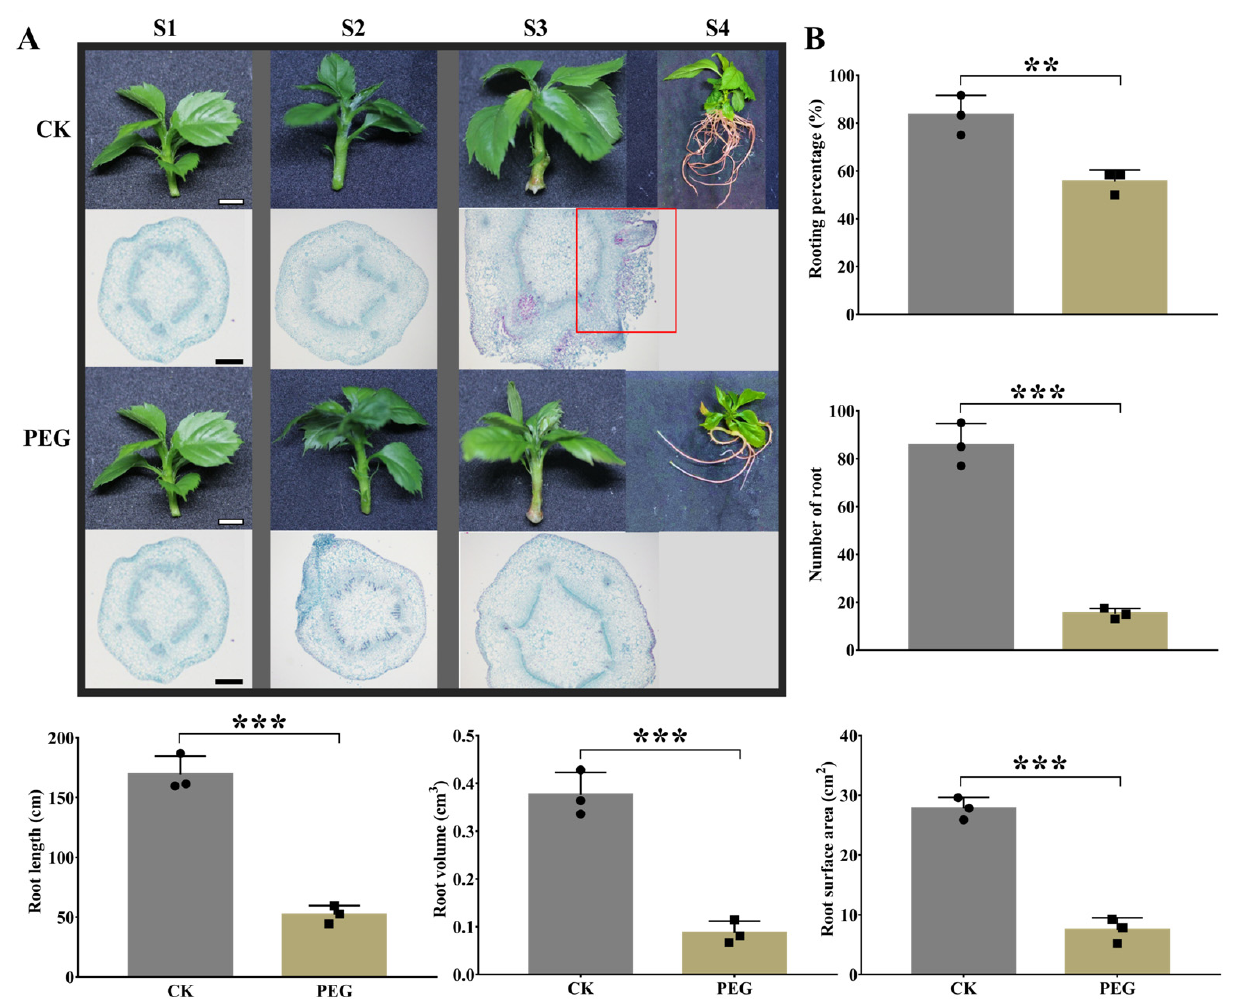
Figure 1. Morphological and anatomical observations were obtained at S1, S2, S3, and S4 after polyethylene glycol (PEG) treatment during adventitious root (AR) formation in GL-3 apple cuttings when compared to a PEG-free control (CK) group. The scale bar for morphology and microscopy photos was 1 cm and 500 µ m, respectively ( A ). Effect of PEG on ARs’ development. Morphological parameters were measured at S4, including rooting percentage, number of roots, root length (cm), root volume (cm 3 ), and root surface area (cm 2 ) ( B ). Error bars refer to the average value ± SD from three biological replicates. Different asterisks indicate significant differences at ** p < 0.01 and *** p <